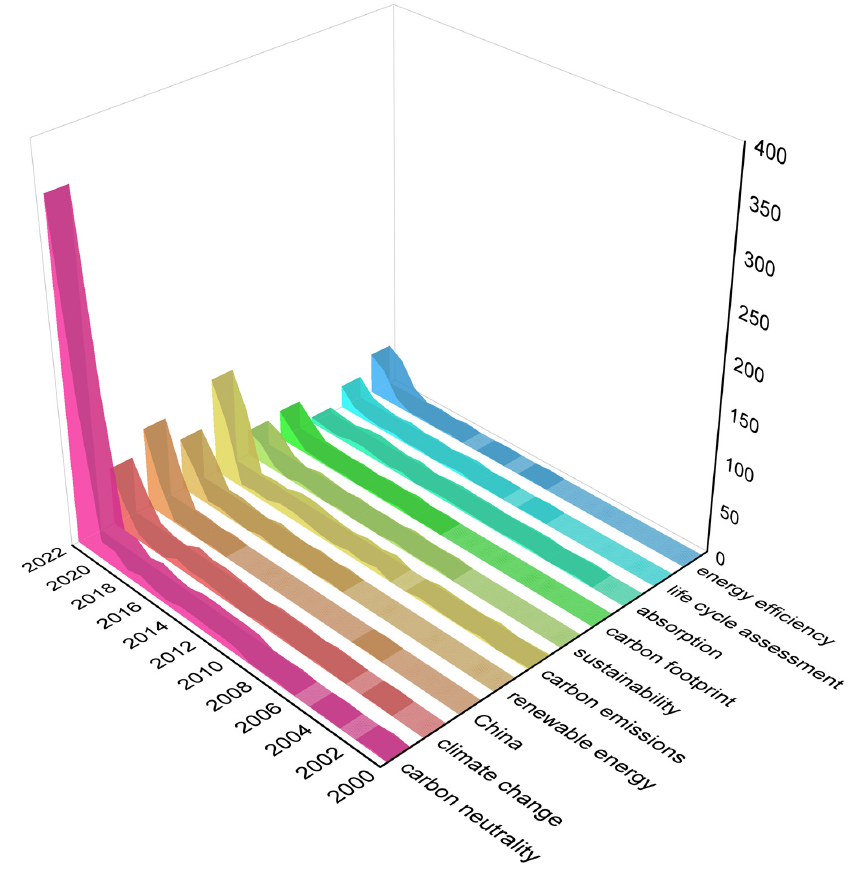
Figure 9. Frequency of the main keywords.